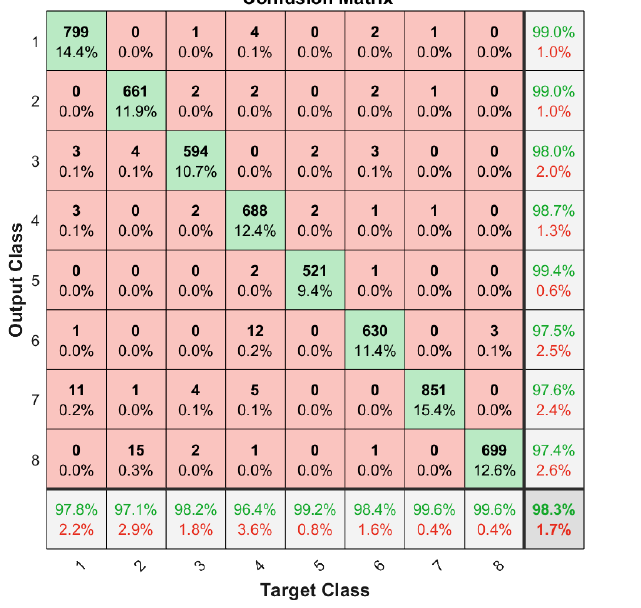
Figure 14. Confusion matrix generated using the ConvAutoencoder